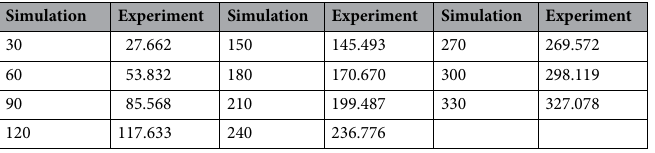
Table 2. Comparison of phase modulation of dual-layer IPS system between simulations and experiments.